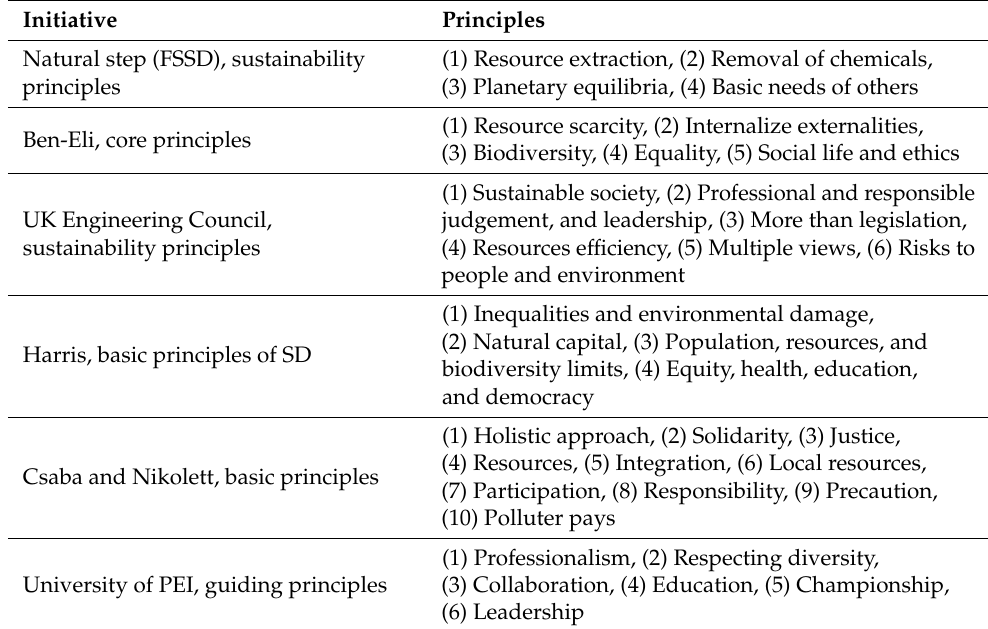
Table 1. An overview of sustainability and Sustainable Development (SD)